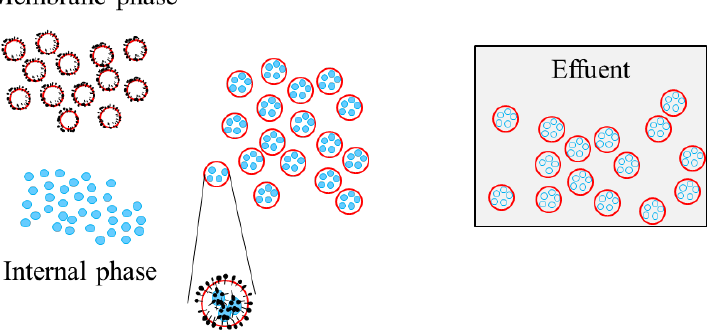
Figure 1. Schematic diagram of W/O-type emulsion film membrane structure.